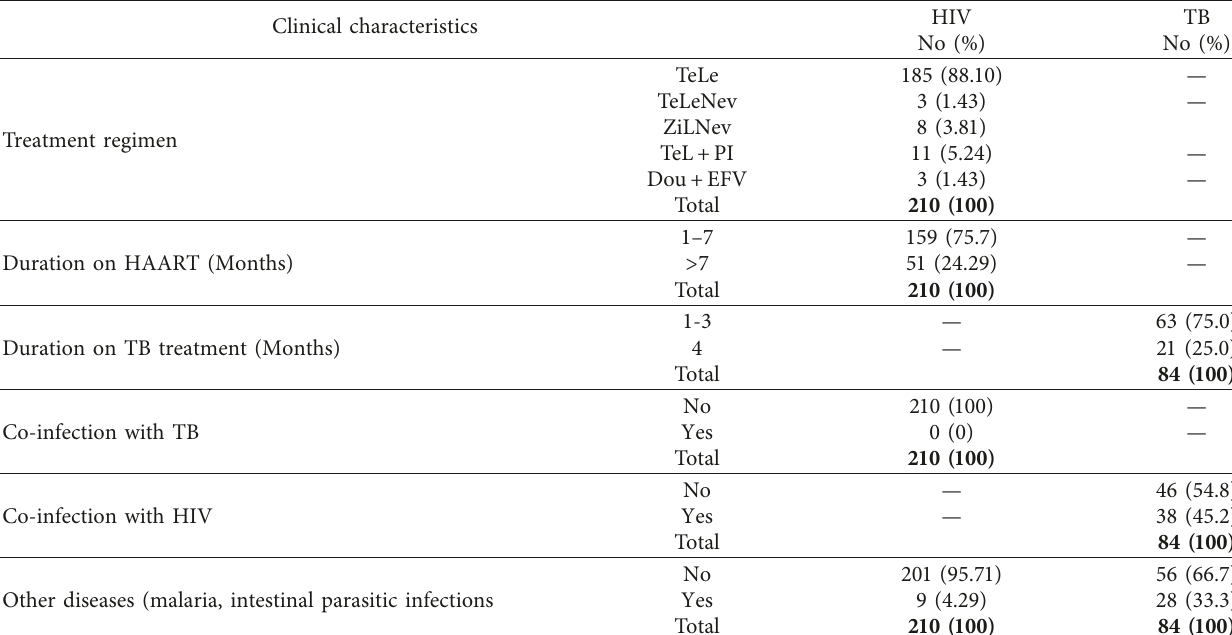
Table 2: Clinical characteristics of HIV and TB participants on treatment in the Buea and Kumba Hospitals. Clinical